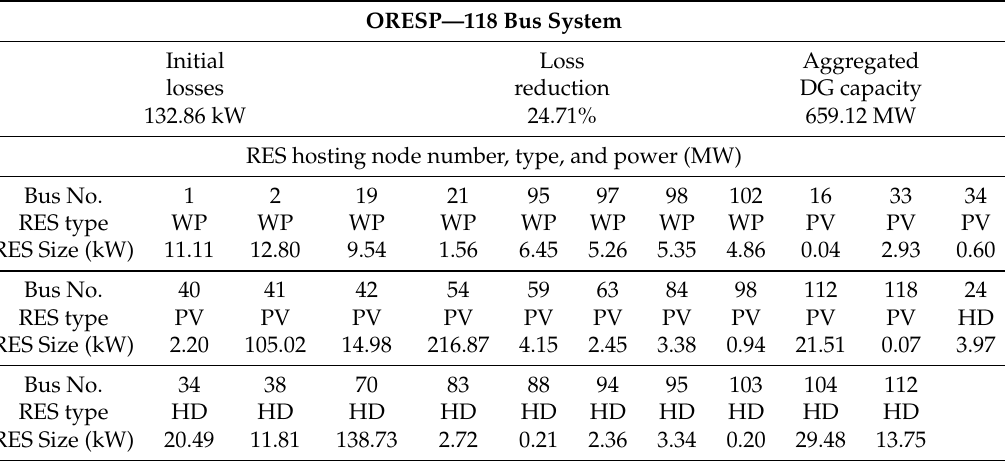
Table 5. ORESP results for 118 bus